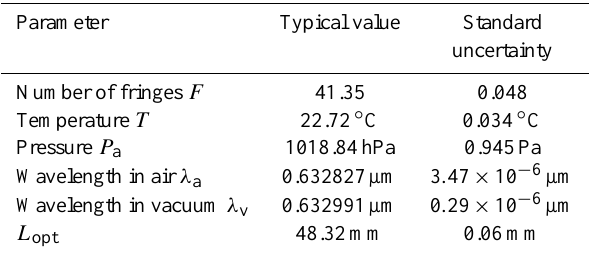
Table 1. Uncertainty budget for the absorption cell light path length